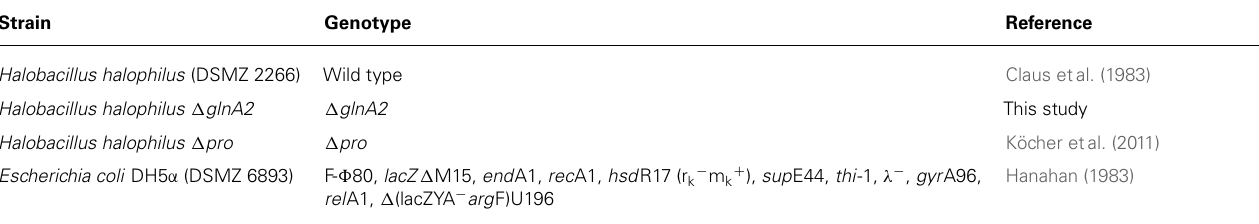
Table 1 | Strains used in this study.